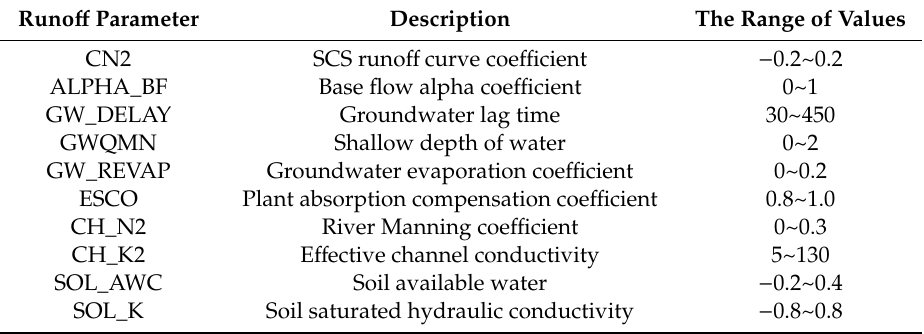
Table 2. Runo ff simulation sensitivity